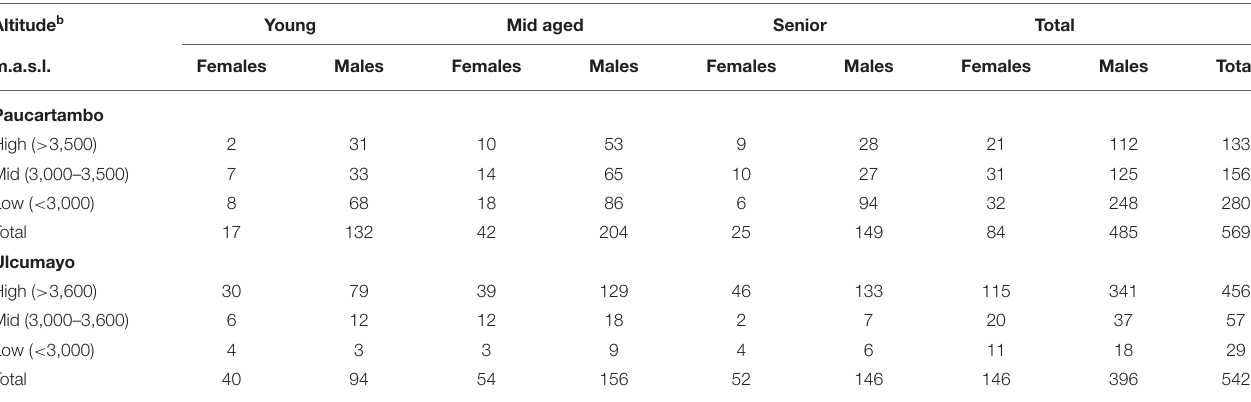
TABLE 2 | Number of respondents in different altitude ranges by age and gender class in Paucartambo and Ulcumayo a . Altitude b Young Mid